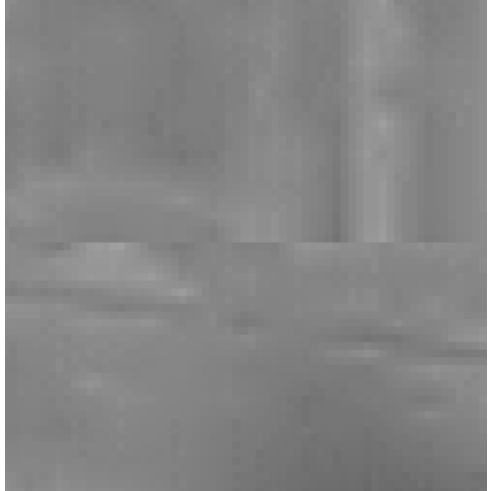
Figure 4. Missing of scanner lines in the right CCD image 3.1 Bundle block adjustment with the left, middle,